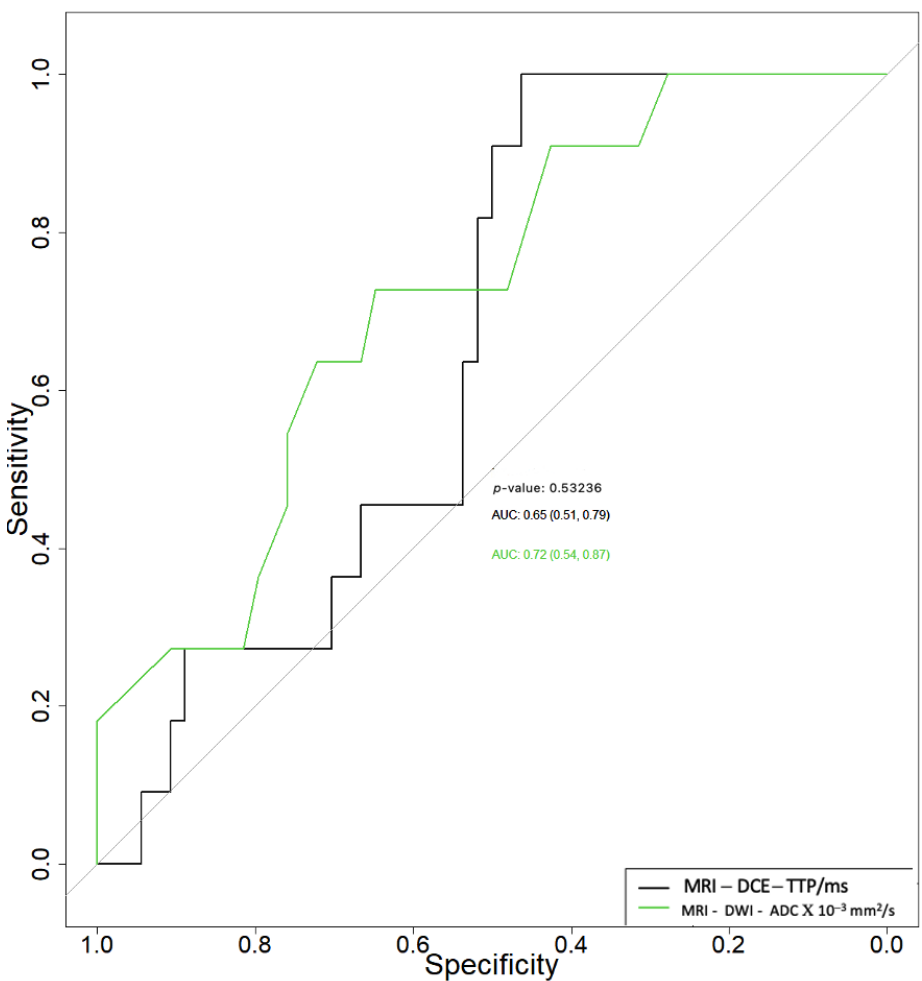
Figure 1. Receiver operating characteristic curves of apparent diffusion coefficient (ADC) and time to peak (TTP) in the differential diagnosis between benign and malignant parotid tumors.